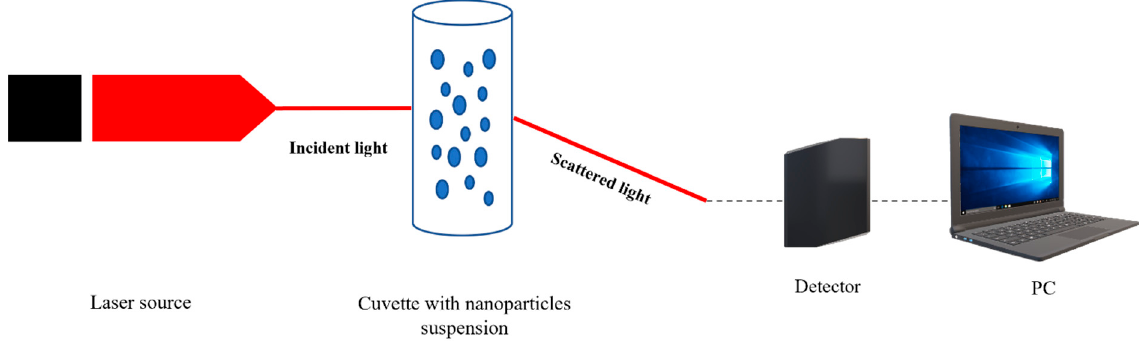
Figure 8. Schematically representation of DLS in nanoparticles suspensions analysis.